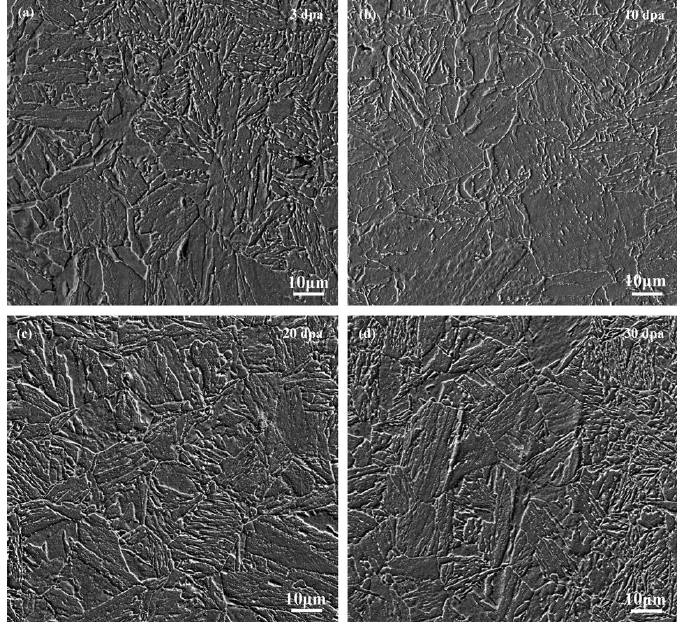
Figure 3. Microstructure of samples after different ion-irradiation doses, ( a ) 3 dpa; ( b ) 10 dpa; ( c ) 20 dpa; and ( d ) 30